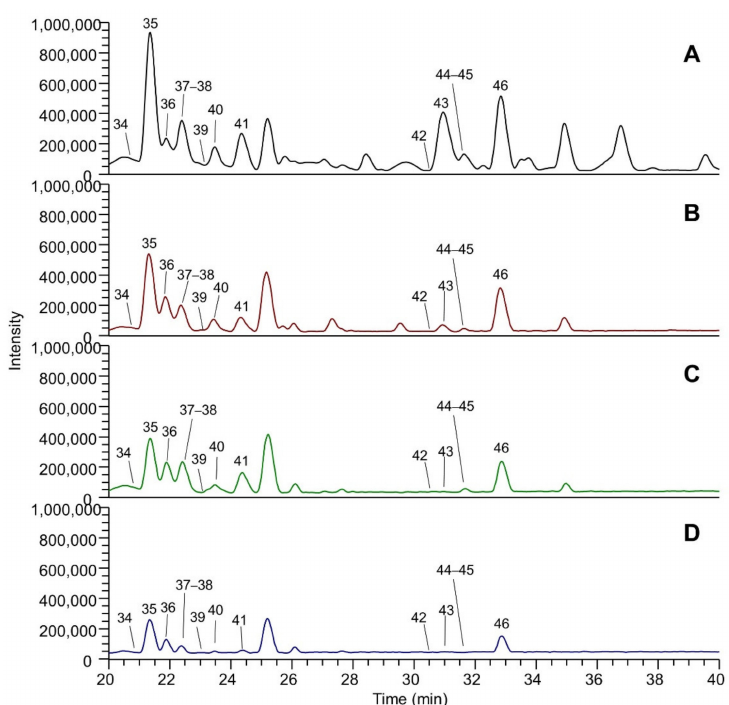
Figure 3. Magnification (range time 20–40 min) of the LC-ESI-(-)-MS total ion currents (TICs) recorded in negative ion mode of the four extracts: ( A ) EtOH-H 2 O 70:30 (% v / v ); extract A; ( B ) water at 100 ◦ C, extract B; ( C ) water at 70 ◦ C extract C; ( D ) water at room temperature, extract D. Identified peaks (group B) are numbered progressively based on the RT and their assignment is reported in Table 5.